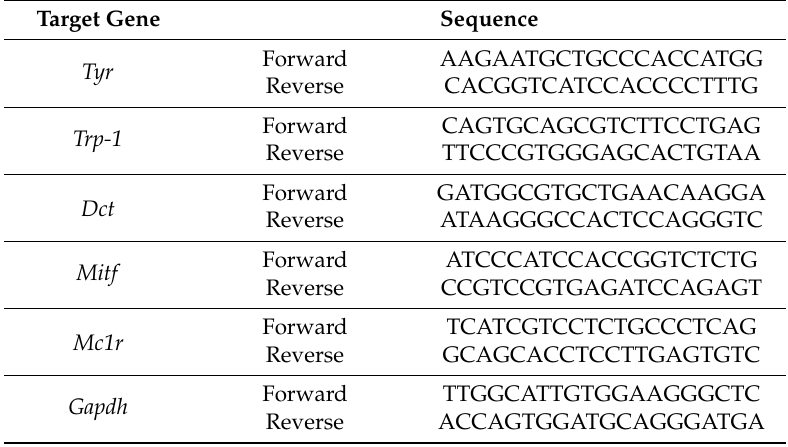
Table 1. Sequences of the primer pairs of specific target